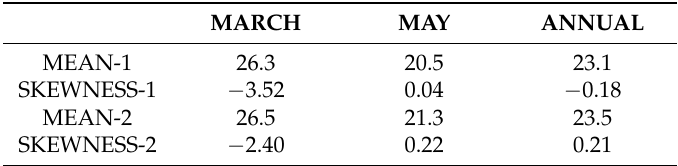
Table 3. Changes in the statistics of the maximum temperature (Index 1 indicates the period 1952–